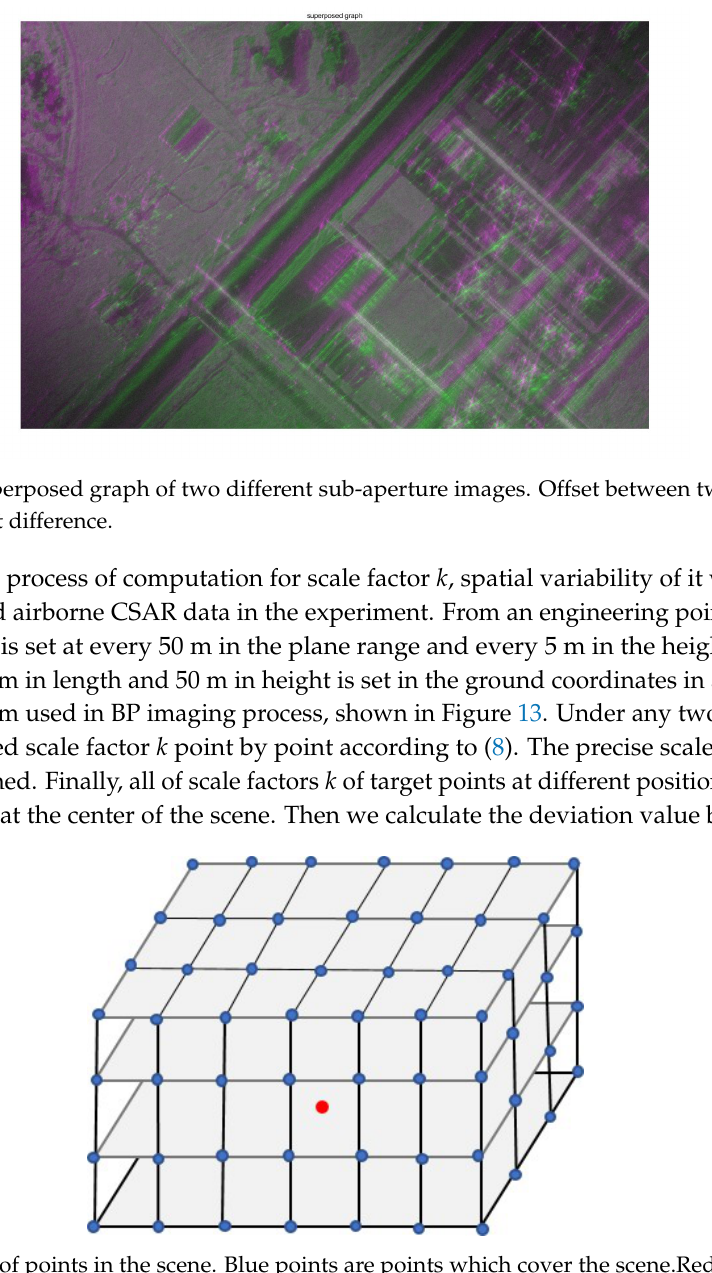
Figure 13. A set of points in the scene. Blue points are points which cover the scene.Red point is the point which is at the center of the